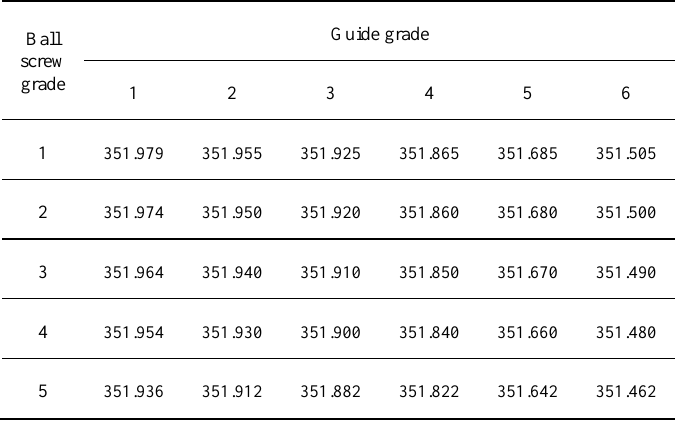
Table 6. the minimum width of the interior rail